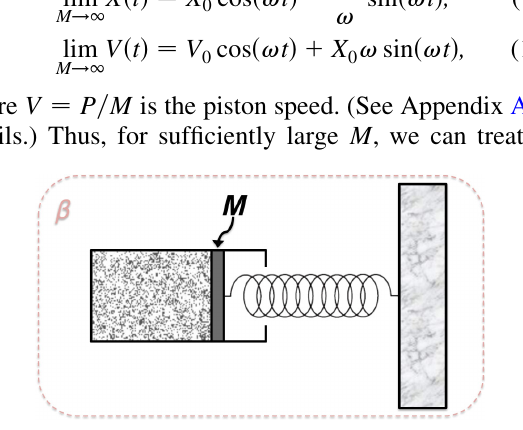
FIG. 2. Example of a work reservoir: The spring is attached to a piston with large mass M and confining a rarefied gas in a cylinder. The gas is in thermal contact with a heat bath of temperature (cid:6) (cid:1) 1